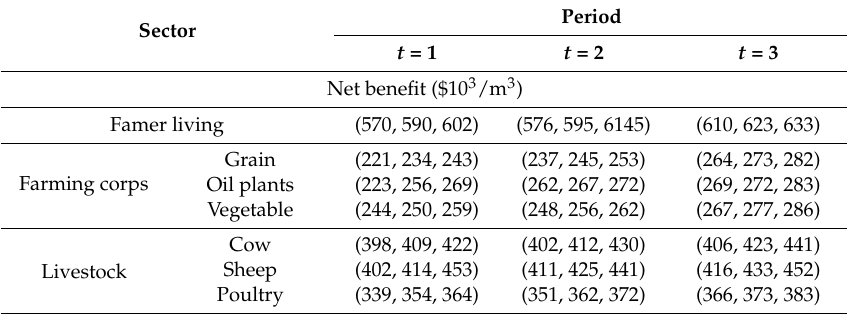
Table 1. Economic